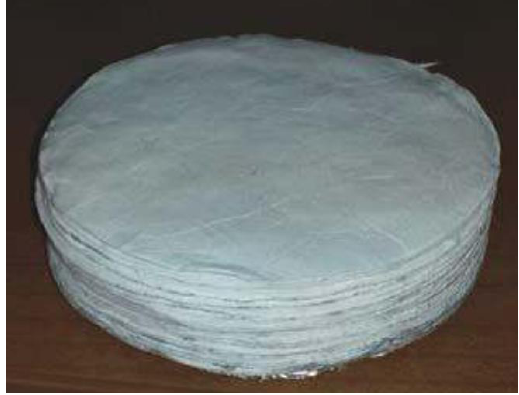
Figure 1. Layers of electrospun silica/PVP blanket.